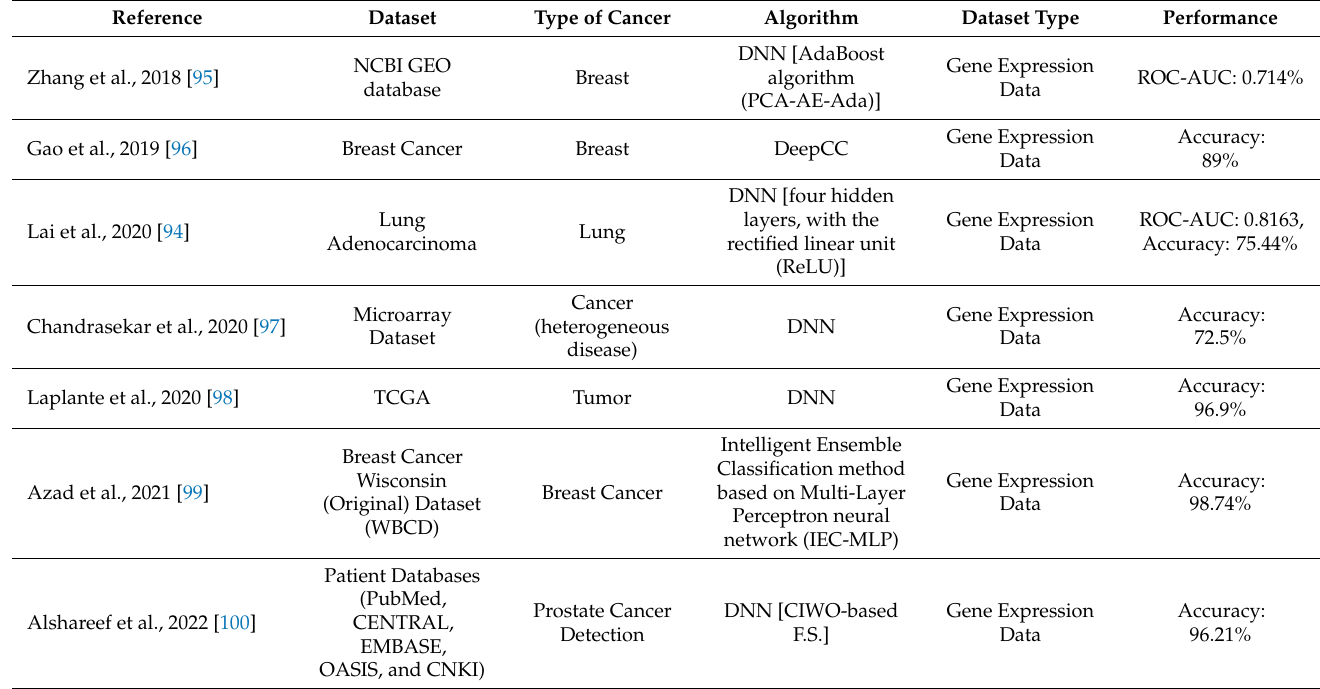
Table 7. Deep learning-based MLP methods for gene expression